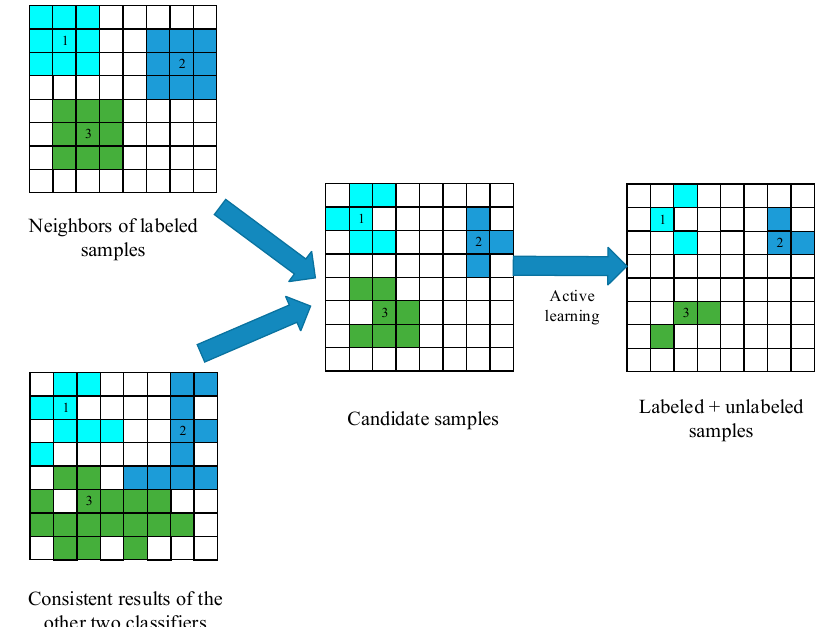
Figure 1. The process of selecting unlabeled samples.